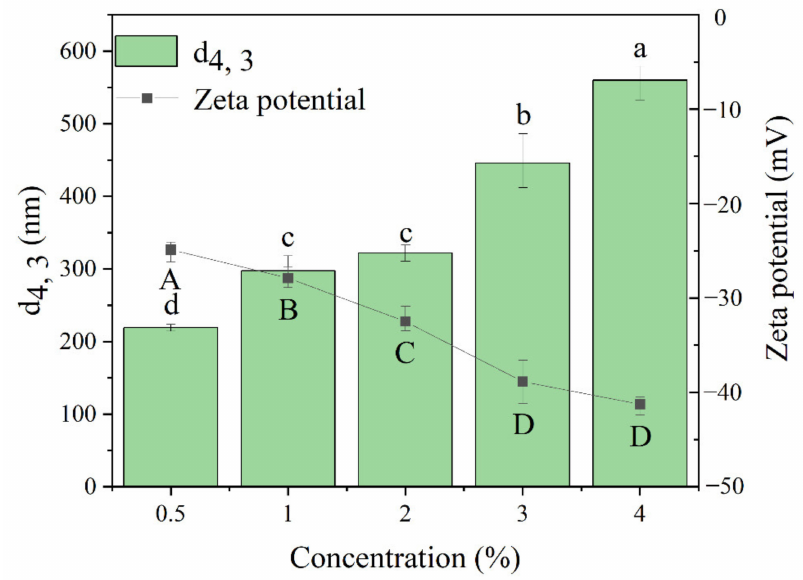
Figure 1. Effect of tee seed cake protein (TSCP) concentrations on the particle size (volume mean diameter d 4, 3 histogram) and zeta potential (line) of nanoparticles fabricated from TSCP (TSCPN). Different lowercase letters indicated significant differences of particle size between treatments ( p < 0.05), and different uppercase letters indicated significant differences of zeta potential between treatments ( p <